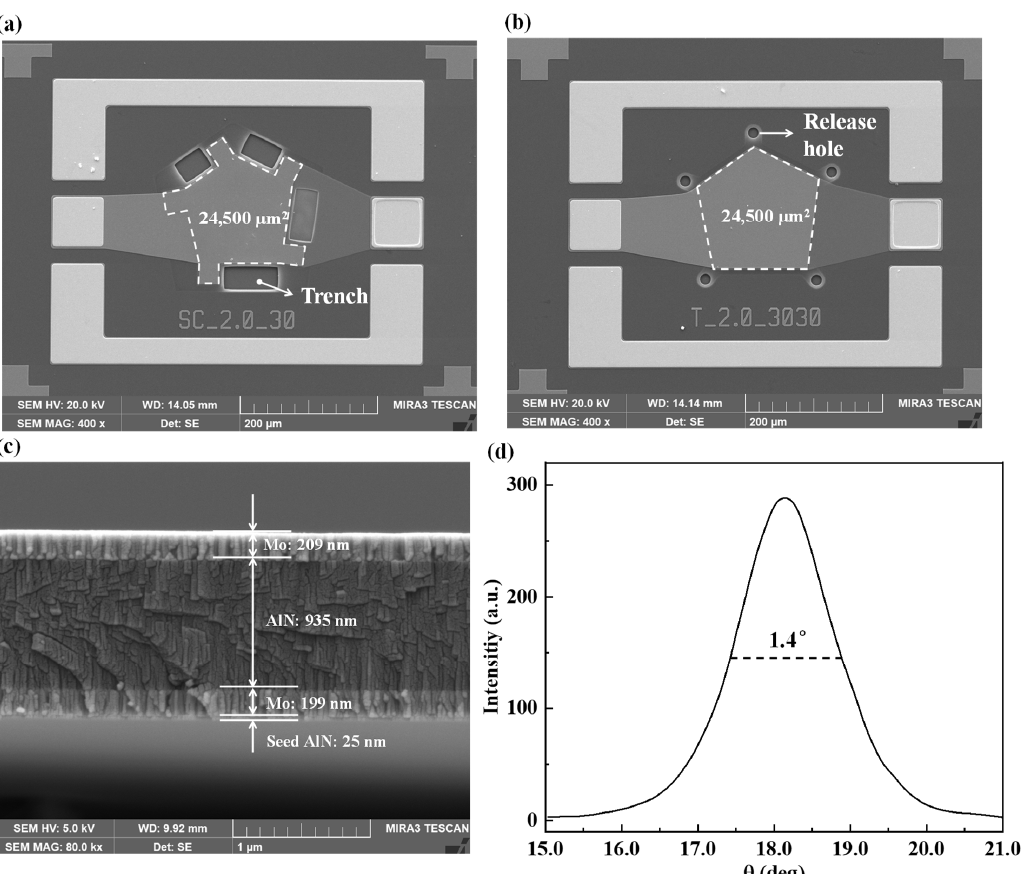
Figure 5. ( a ) SEM image of the fabricated FBAR with support columns. ( b ) SEM image of the traditional FBAR. ( c ) Cross-sectional SEM image of the piezoelectric stack. ( d ) The measured XRD rocking curve of the AlN layer.